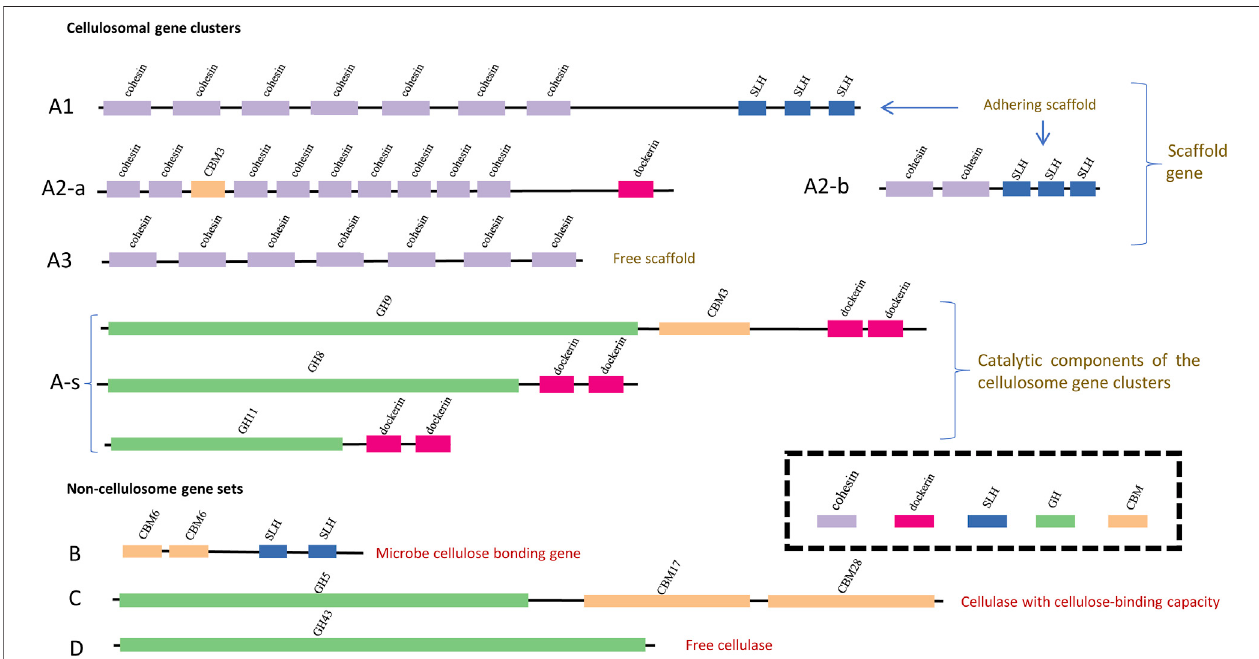
FIGURE 1 | Schematic visualization of the clustering patterns of CAZy modules along different types of cellulose-active genes. The GH modules, the CBM modules, the SLH module, the dockerin module and the cohesion module are represented with bars in green, yellow, blue, pink and purple, respectively; width and position of each bar indicates the length (bp) of each module and its position along genes. De fi nition of the gene types are the same as that summarized in Table 1 : genes of type (A1,A2-a,A2-b) are adhering scaffold genes; genes of type (A3) represent non-adhering scaffold backbone genes (missing the SLH module); genesoftype (A-s) arethecatalyticcomponentsofthecellulosomegeneclusters;genesoftype (B) encodethemicrobe-celluloseadhesionprotein;genesoftype (C) encode cellulase with cellulose-binding capacity and genes of type (D) encode free cellulase (missing both the CBM module and the SLH